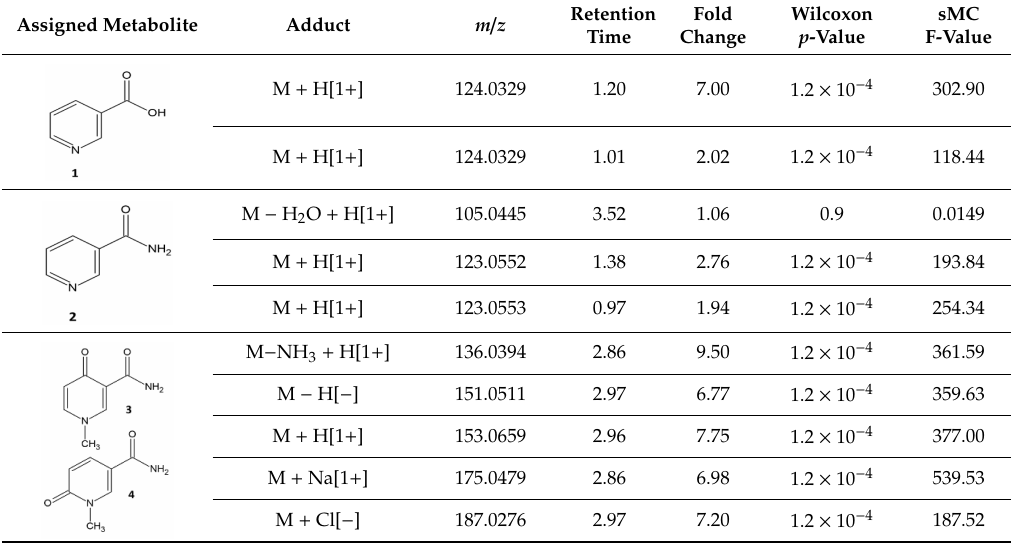
Assigned metabolites of vitamin B3 metabolism: the degradation